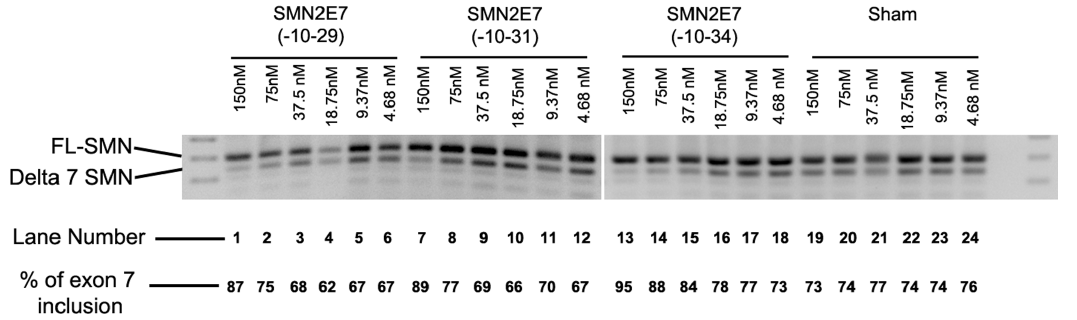
Figure 4. A titration study of the three lead PMOs: Splicing pattern of SMN transcript in type I SMA patient cells transfected with PMOs or unrelated negative control (Sham PMO) using lipofectin.at concentrations indicated. The percentage of SMN2 exon inclusion as determined by densitometric analysis of RT-PCR gel images is also shown.